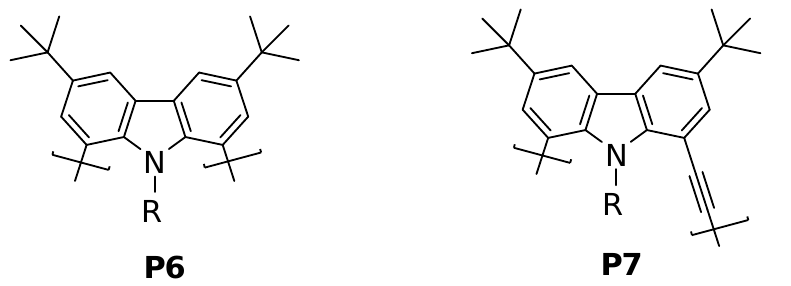
Figure 6. Chemical structure of P6 and P7 .